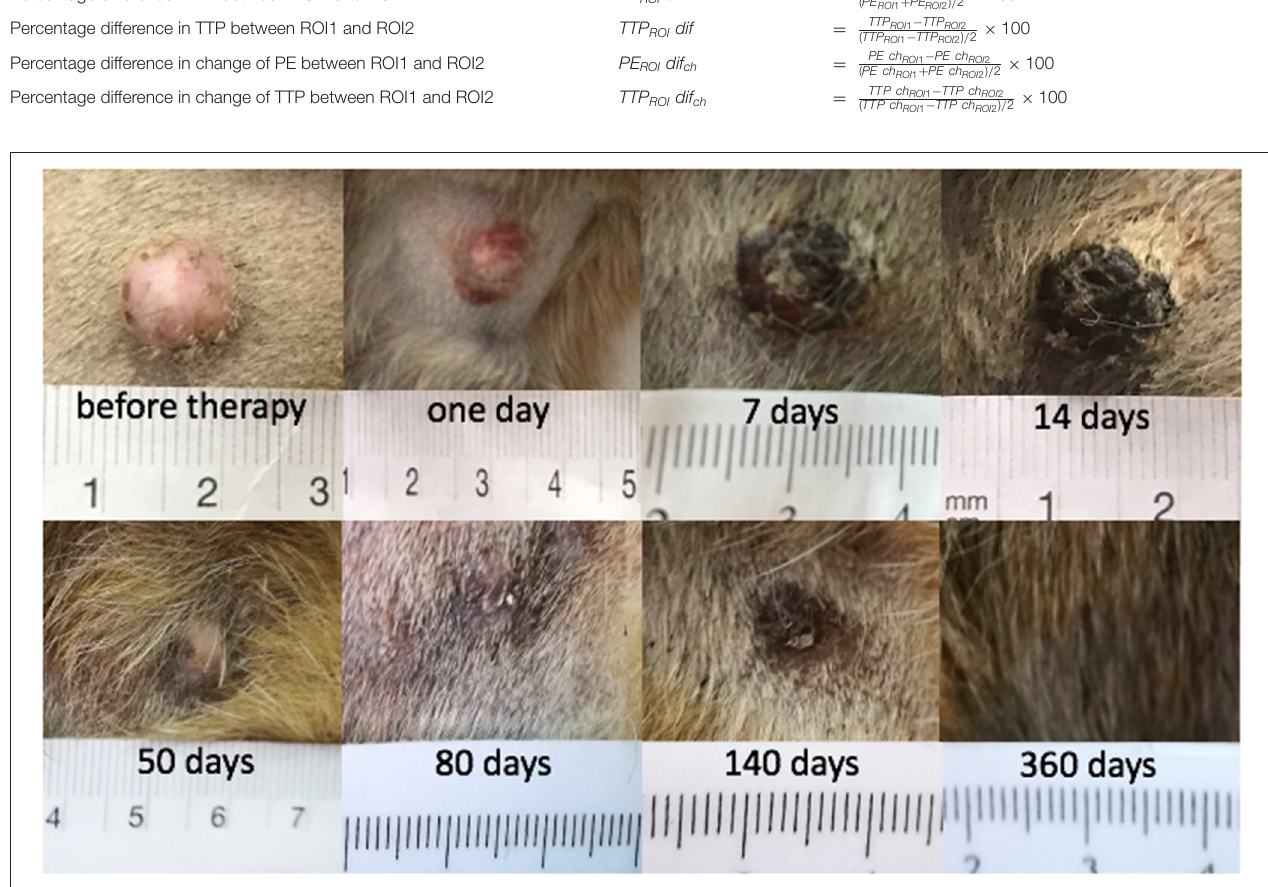
FIGURE 2 | Mast cell tumor in dog 1 where a complete response (CR) was achieved after electrochemotherapy (ECT) combined with gene electrotransfer of plasmid DNA encoding interleukin IL-12 (GET